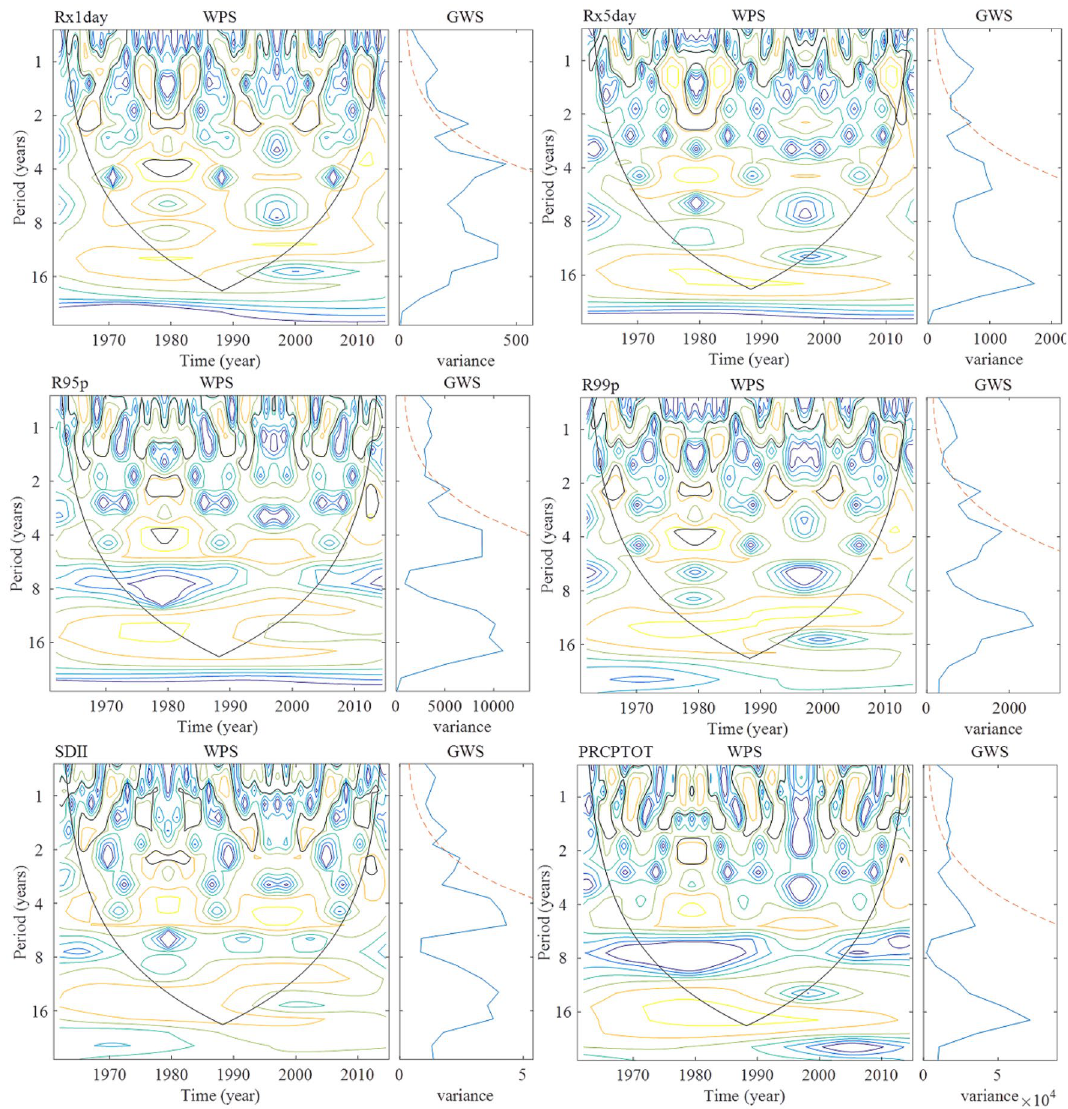
Figure 8. Wavelet power spectrum and global wavelet spectrum for the time series of indices related to the amount of precipitation in Shandong from 1961 to 2015 (The range surrounded by the black outline in WPS refers to passing 95% of the significance level, the red dashed line in GWS is the 95% confidence spectrum